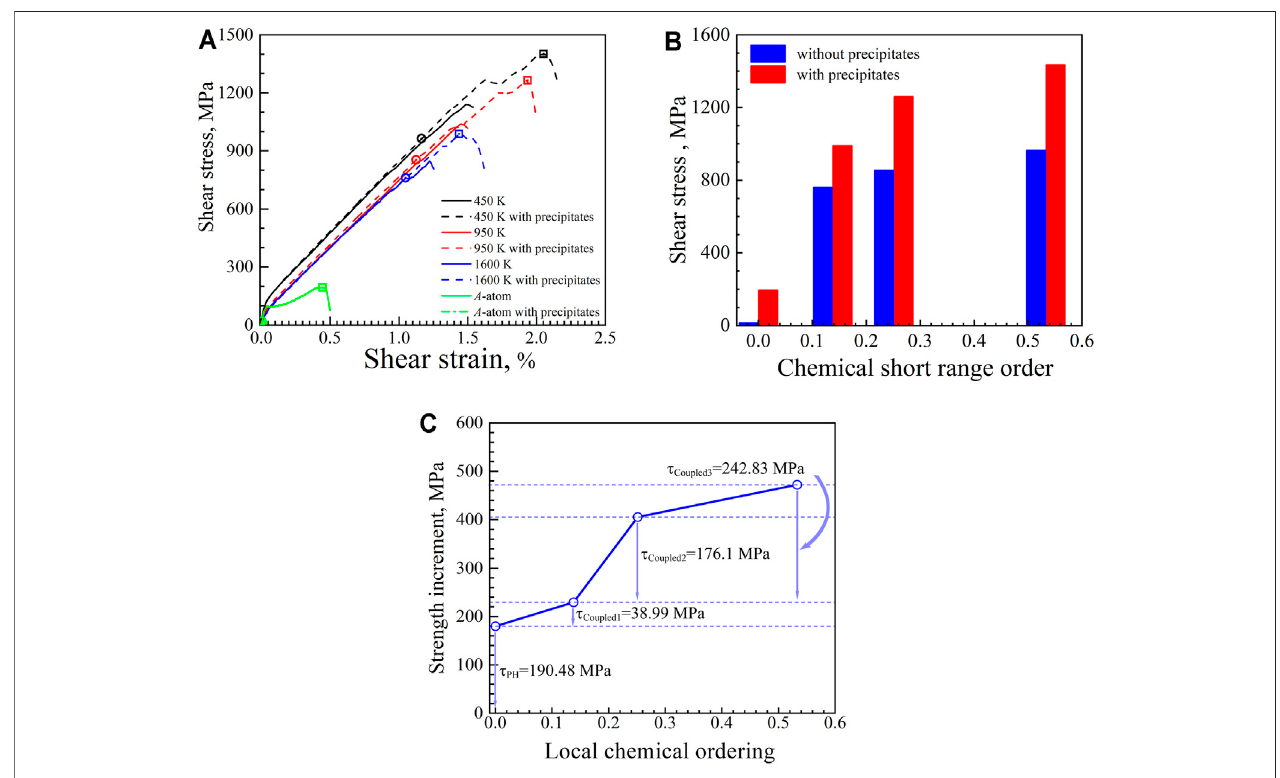
FIGURE6| Couplingstrengtheningbylatticedistortion,localchemicalordering,andnanoprecipitates. (A) Simulatedshearstressstraincurvesforvarioussamples. (B) The critical shear stress ass a function of the degree of local chemical ordering. (C) The coupling strengthening effects as a function of the degree of local chemical